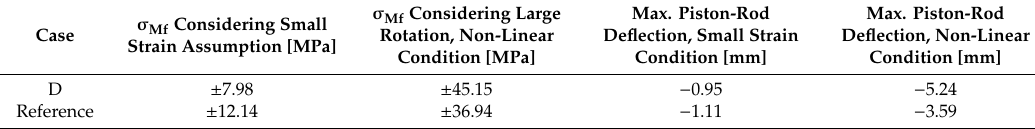
Table 9. The stress values and maximum deflection at the rod.